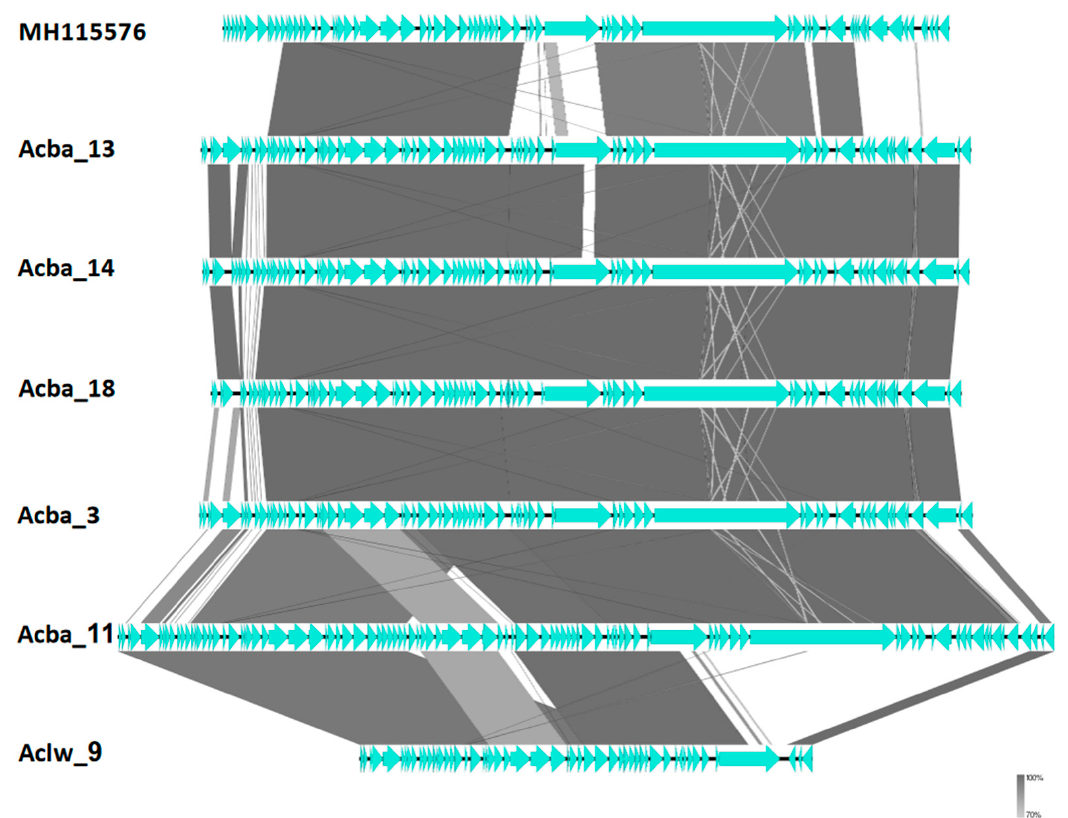
Figure 4. Comparison of genomes between researched phages and the reference phage for Shemyakinvirus genus. Genomes were compared using blastn and represented by the Easyfig software. The genome of the representative phage is on the top. Horizontal black lines (genome) with blue arrows (ORFs) represent phage genomes. Gray, thick, vertical lines represent similar fragments of genomes between phages. Thin gray or white lines represent similarity between short, internal repeats found in compared genomes.